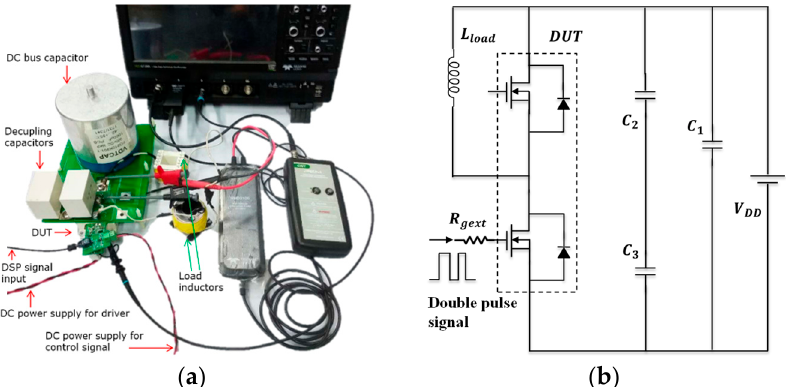
Figure 3. The inductive load double pulse test (DPT) circuit platform: ( a ) physical picture, ( b ) schematic diagram of circuit.